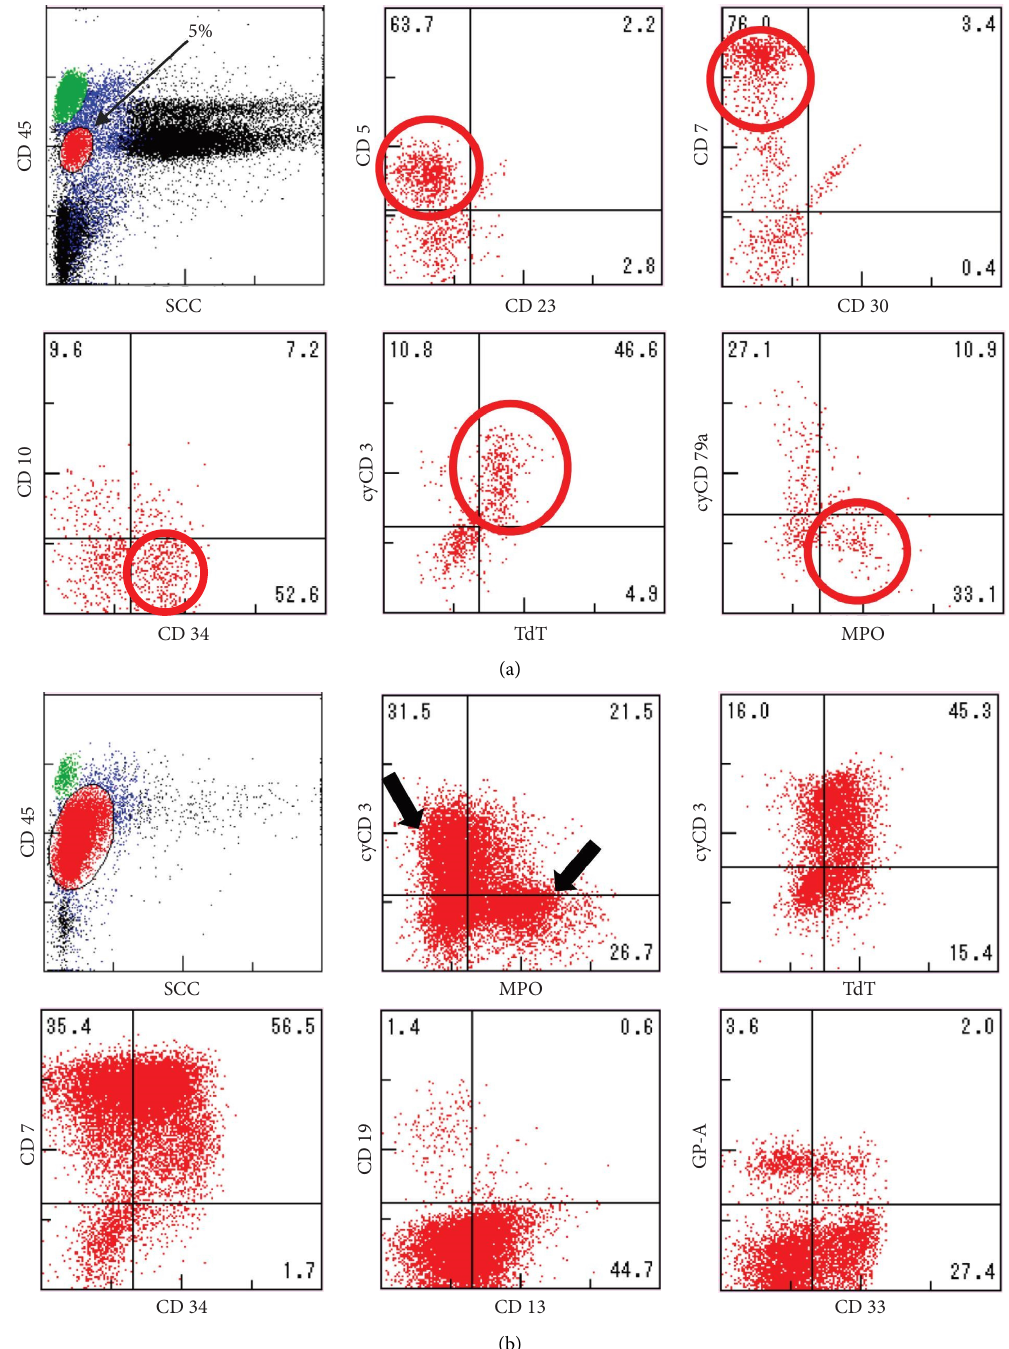
Figure 2: Flow cytometry analysis of bone marrow cells. (a) Flow cytometry showed a small immature cell population coexpressing Tcell and myeloid markers. (b) Two populations of leukemic cells were found: one with myeloperoxidase (MPO) strongly positive and cy- toplasmic CD3 (cyCD3) weakly positive cells and the other with MPO weakly positive and cyCD3 strongly positive cells. cyCD3, cytoplasmic CD3; MPO, myeloperoxidase; TdT, terminal deoxynucleotidyl